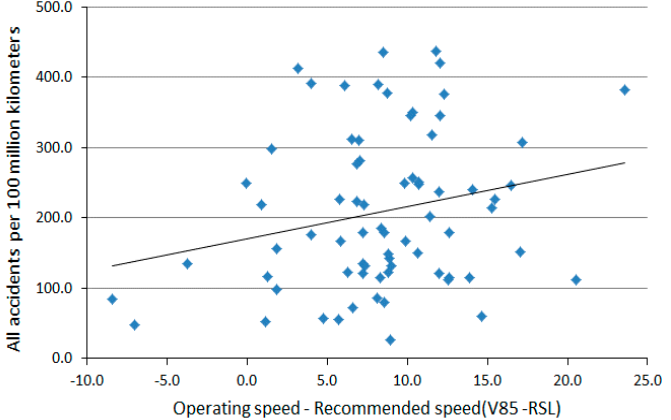
Figure 18. Accident rate as a function of speed difference (V85-RSL). Table 13. Two-sample t-test for the speed difference (V85-RSL) between the high and low accident rate groups.